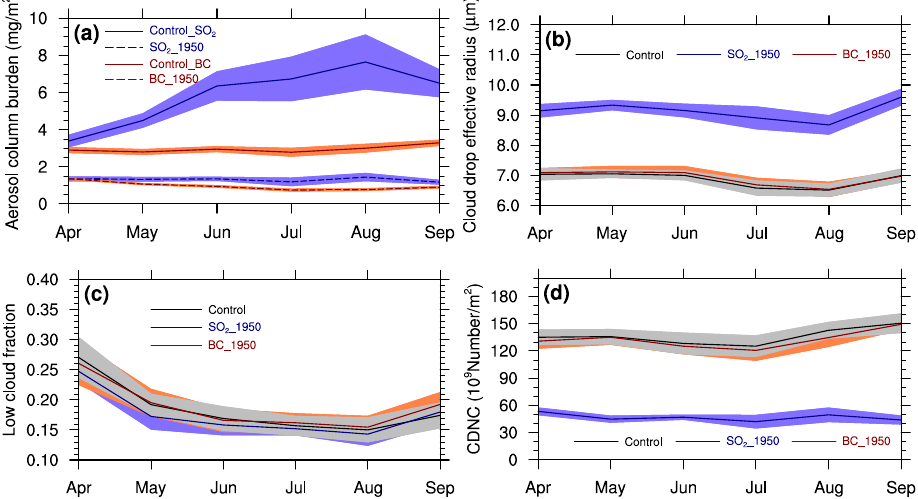
Fig. 4. (a) Eighteen-year (1983–2000) monthly and area-mean aerosol column burden over East Asia. Units: mgm − 2 . (b) Eighteen-year (1983–2000) monthly area-mean vertical mean cloud drop effective radius over East Asia. Units: µ m. (c) Eighteen-year (1983–2000) monthly and area-mean low cloud fraction over East Asia. Units: 1. (d) Eighteen-year (1983–2000) monthly and area-mean cloud droplet number concentration. Units: 10 9 numberm − 2 . Shading colours along each line are standard deviations calculated using eighteen-year monthly data.